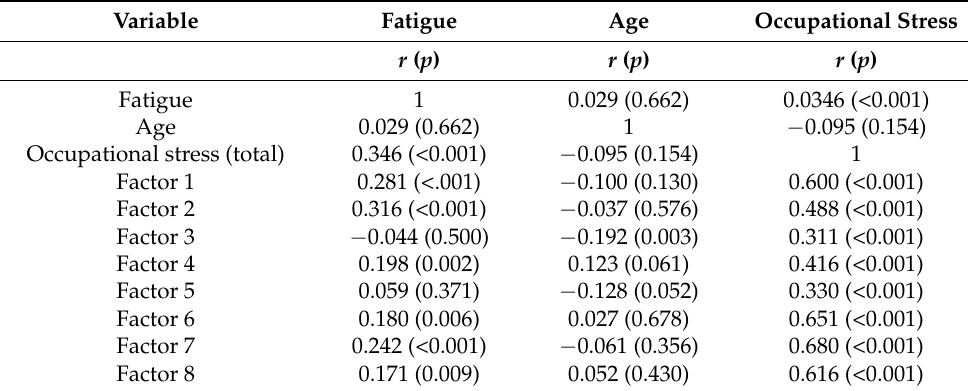
Table 3. Correlation between fatigue, age, and occupational stress (N =